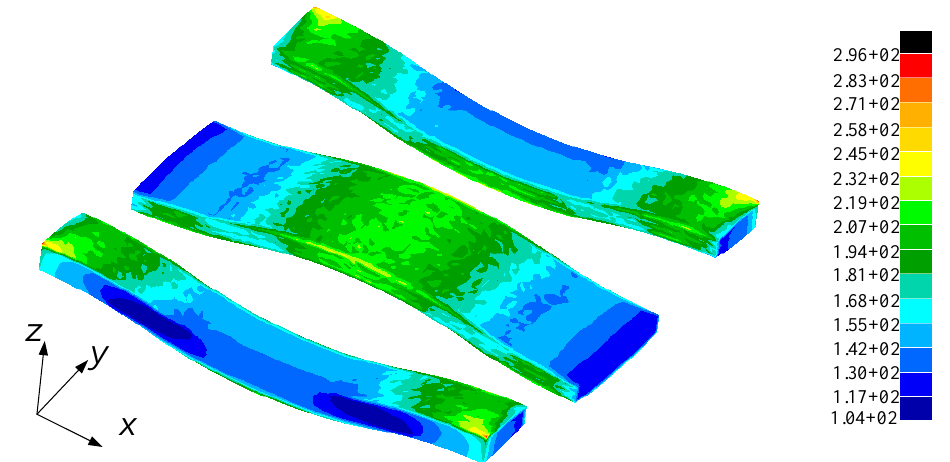
Figure 5. Yarn stress distribution in X direction. The meso-sub-models of 2-D SiC/SiC with peak fatigue loads of 155 MPa, 150 MPa, 145 MPa, 140 MPa, 135 MPa, and 130 MPa were calculated respectively, and the fatigue performance analysis was carried out by using the fatigue life calculation process of ceramic matrix composites based on the above sub-model, calculate the life of 2-D braided ceramic matrix composites under the corresponding stress level. Take the experimental data in [50]